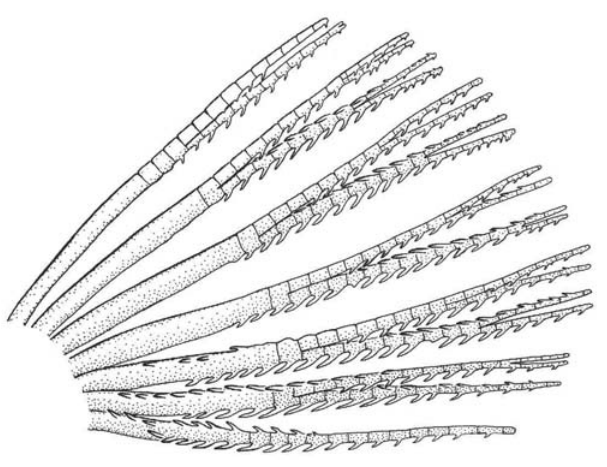
Fig. 57. Mimagoniates lateralis , adult male, USNM 236088, 31.6 mm SL; pelvic-fin rays, ventral view, left